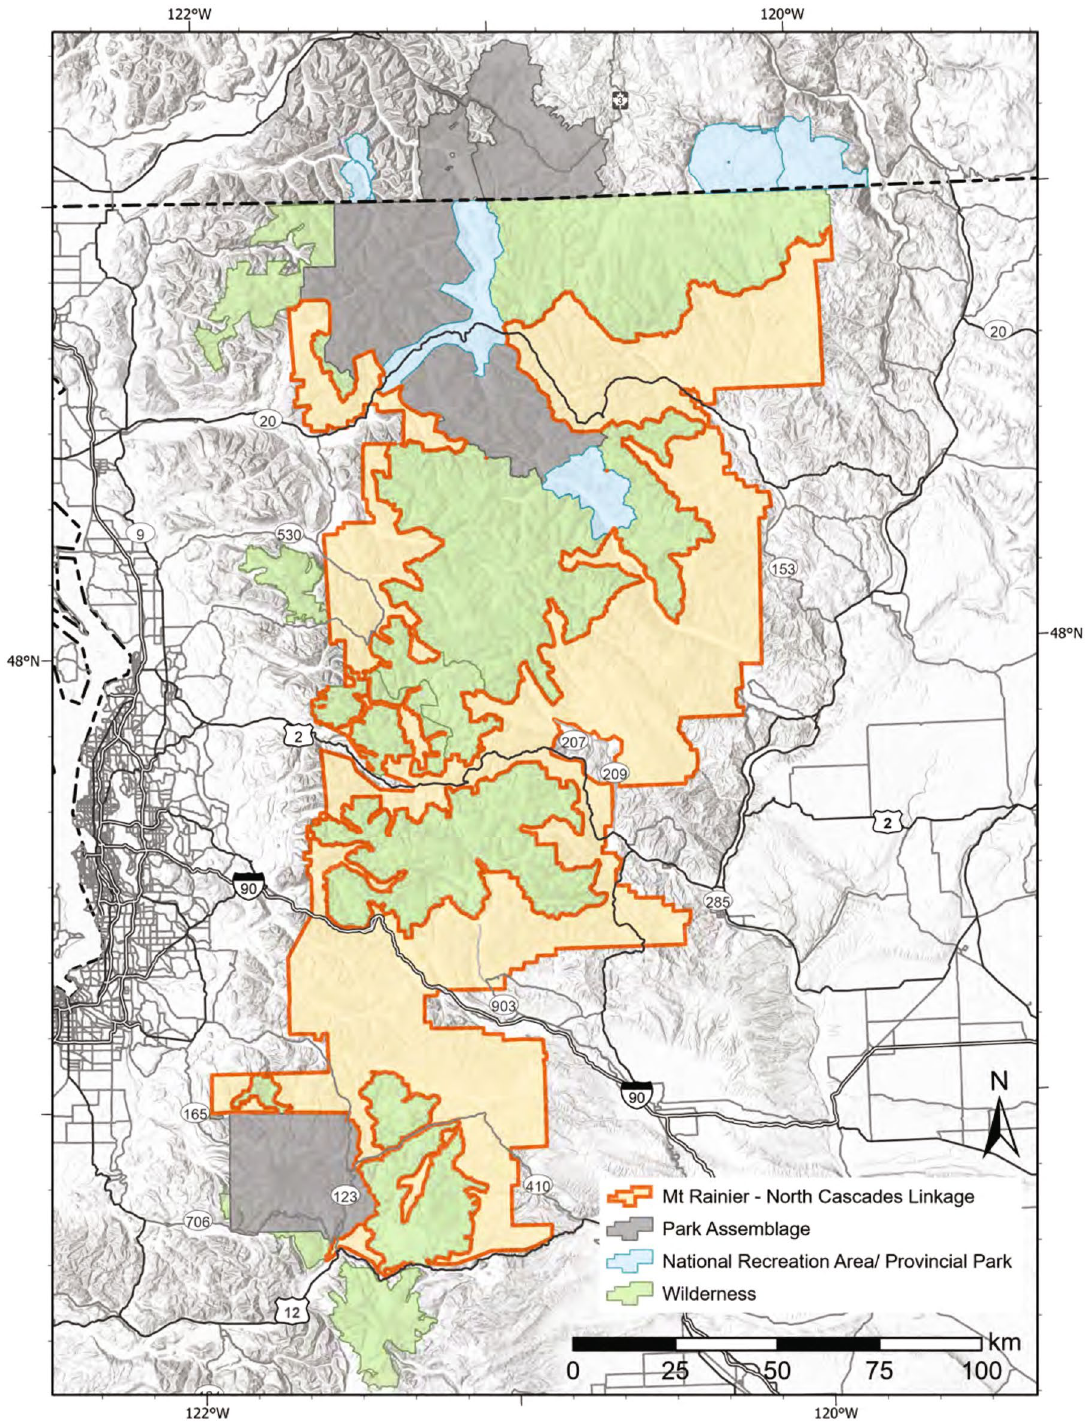
Figure 3. Location of identified multi-species linkage and wilderness areas that intersect the linkages between Mount Rainier National Park and the North Cascades park assemblage in the north Cascades mountain